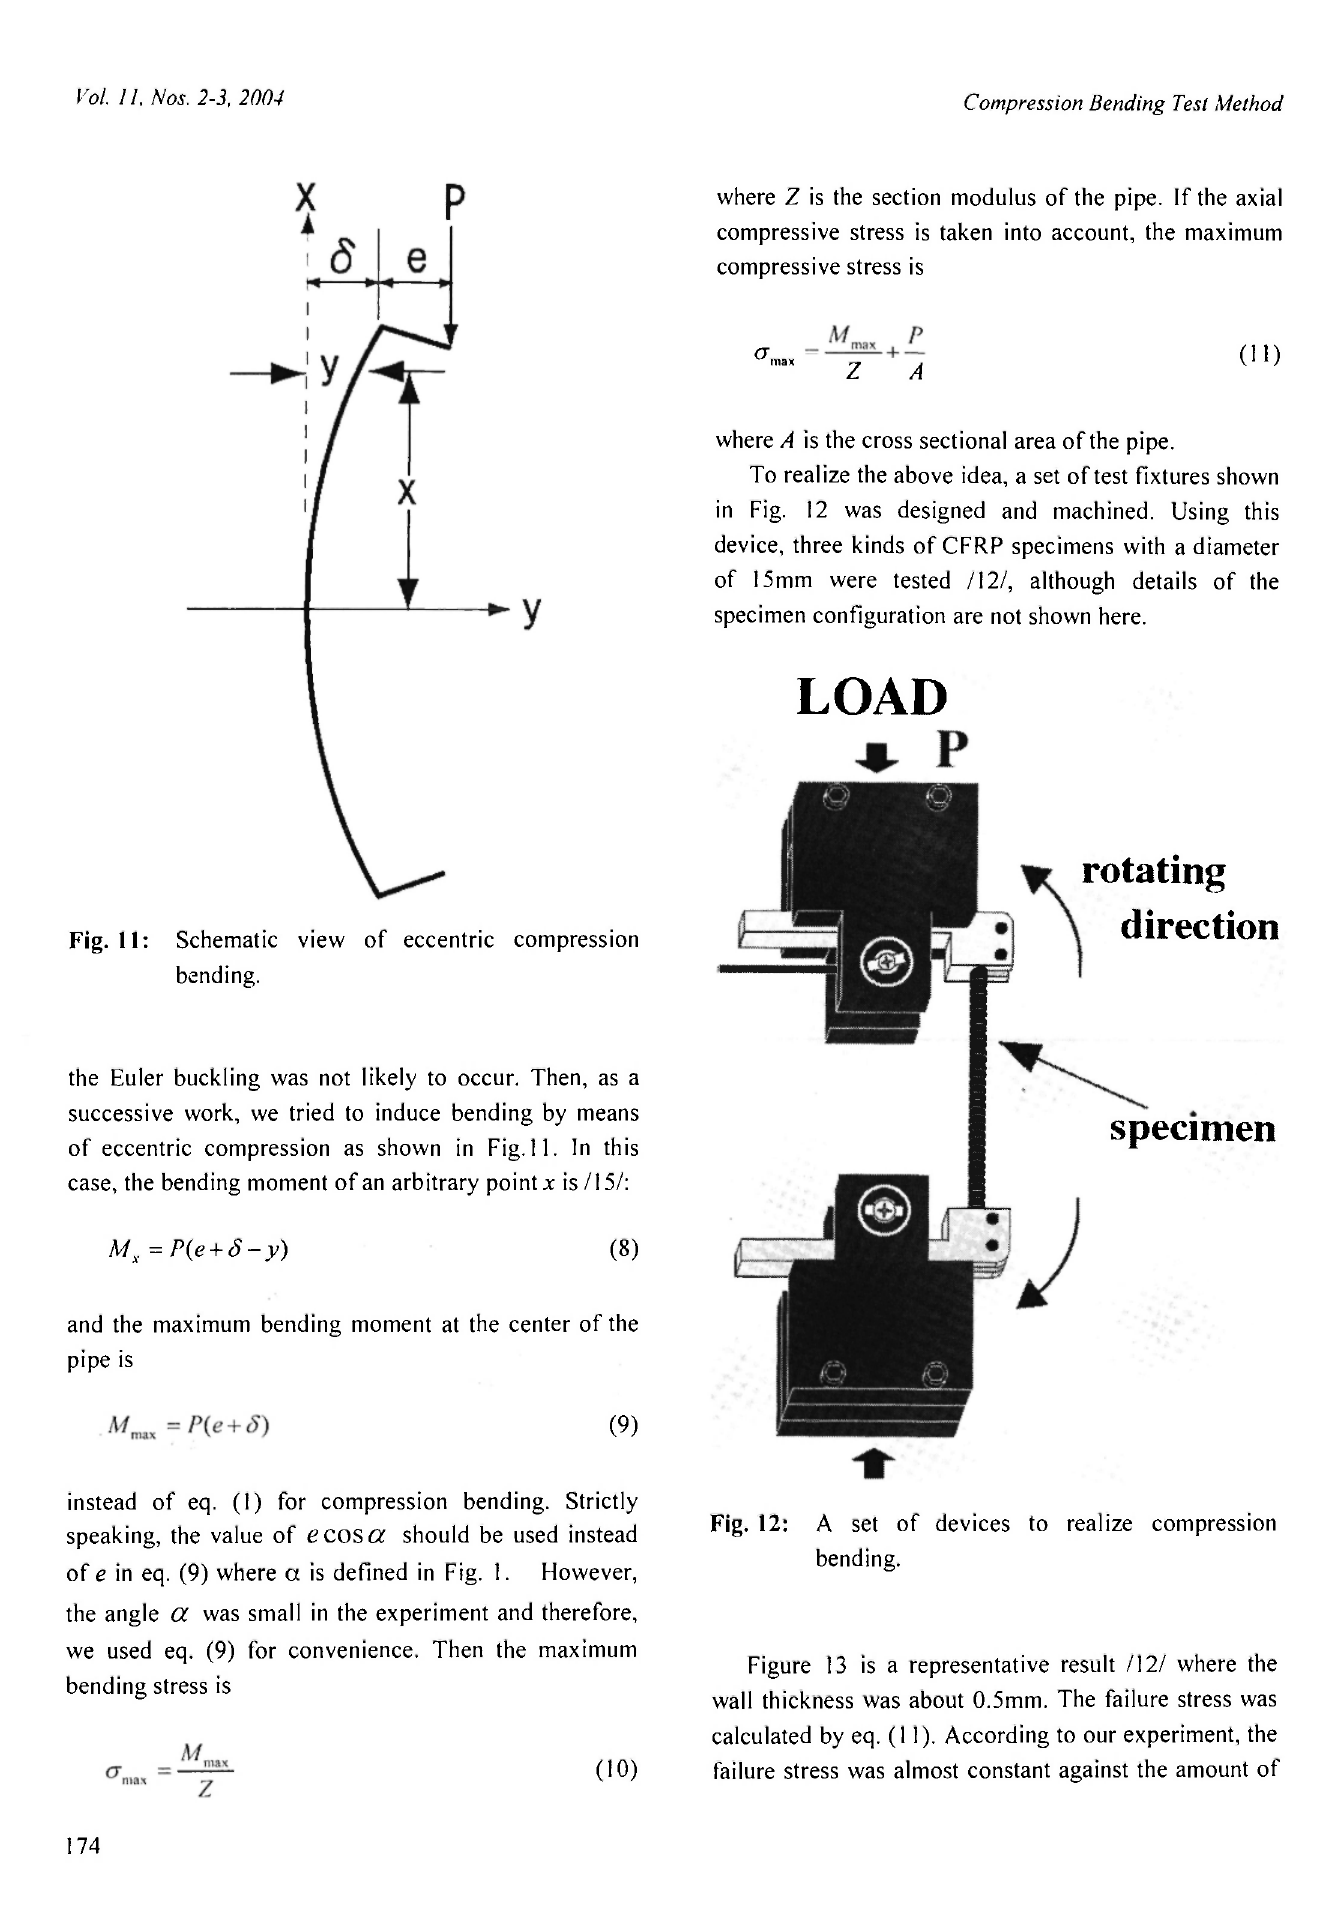
Fig. 12: A set of devices to realize compression